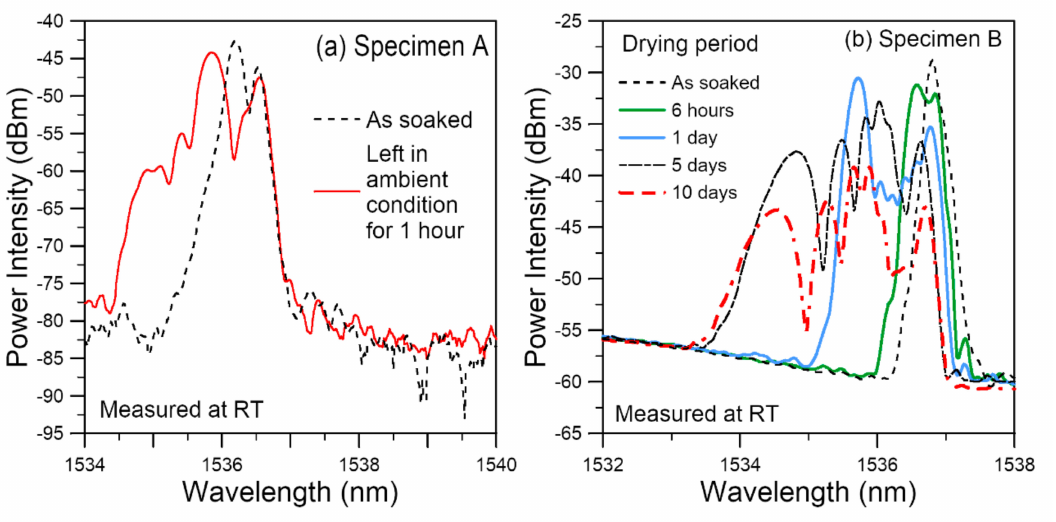
Figure 8. Evolution of FBG spectra during drying in: ( a ) ambient condition for 1 h; ( b ) in a desiccator for 10